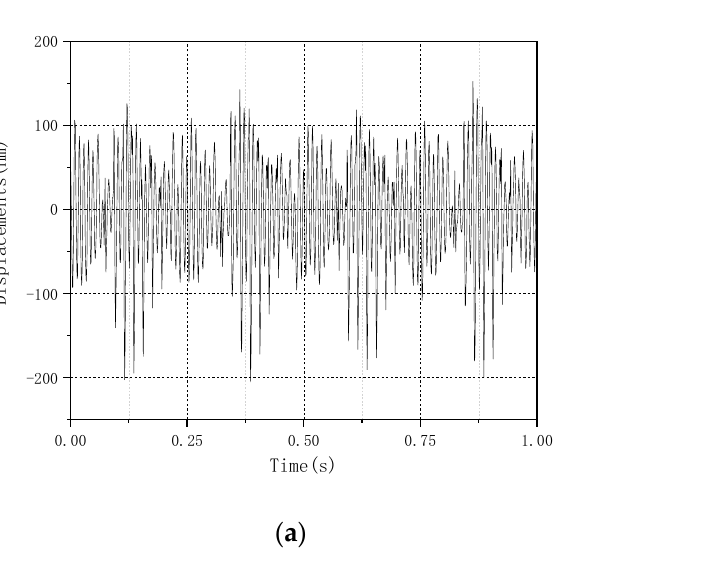
Figure 8. Vibration displacement of iron core with 2 Hz inter-harmonics in excitation; ( a ) time-domain waveform; ( b ) spectrum analysis.